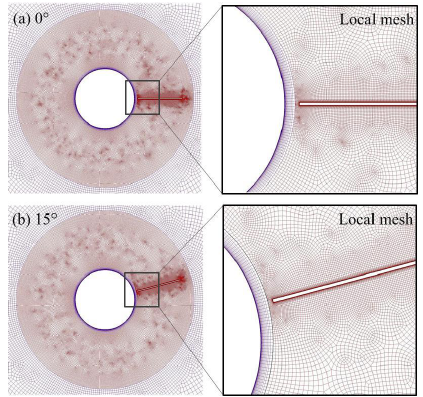
Figure 5. Computing mesh at different rotation angles: ( a ) θ = 0°, and ( b ) θ = 15°.